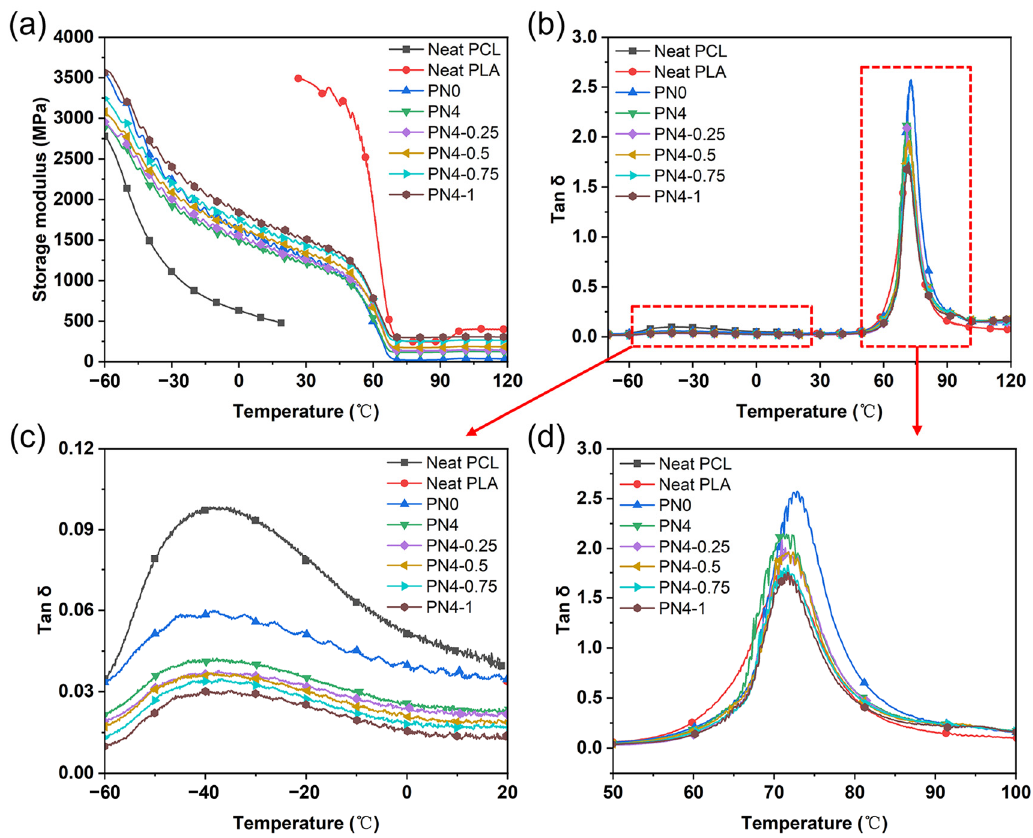
Figure 7. DMA curves measured for the PLA/PCL nanocomposites: ( a ) storage modulus, tan δ in the temperature range of ( b ) − 80–120 ℃ , ( c ) − 60–20 ℃, and ( d ) 50–100 ℃ . Table 5. DMA data of the PLA/PCL nanocomposites derived from the DMA curves.